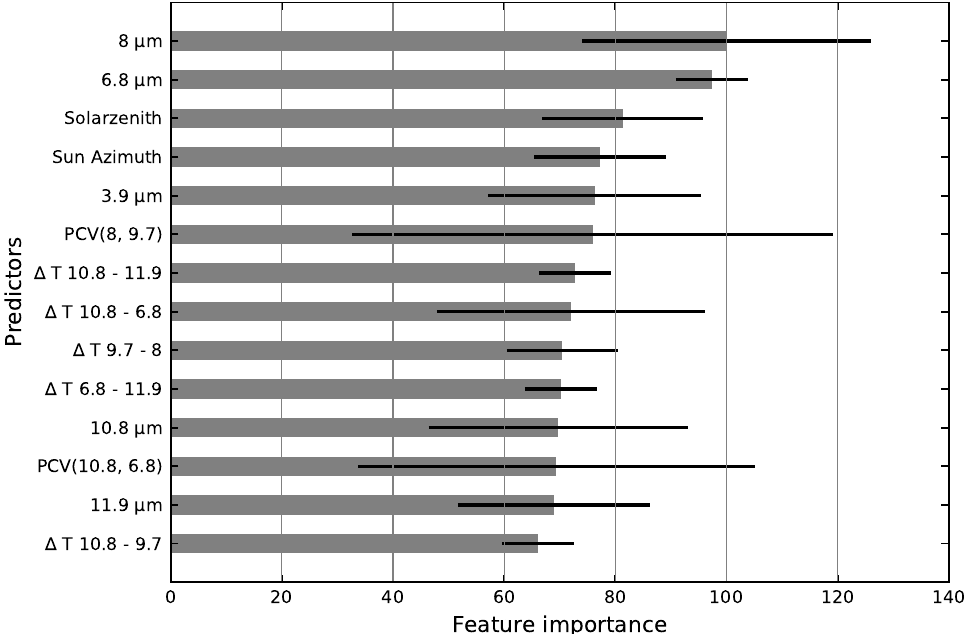
Figure 3. Mean feature importances with standard deviations based on a randomly selected subset of the training data used for the precipitation rates retrieval. The most important feature is set to 100 ( x -axis) and the other features were depicted accordingly. The standard deviation from each predictor was used to calculate the error bars. Depending on the variability of the errors, few of them exceed 100. PCV = pseudo cross variogram. ∆ T = band